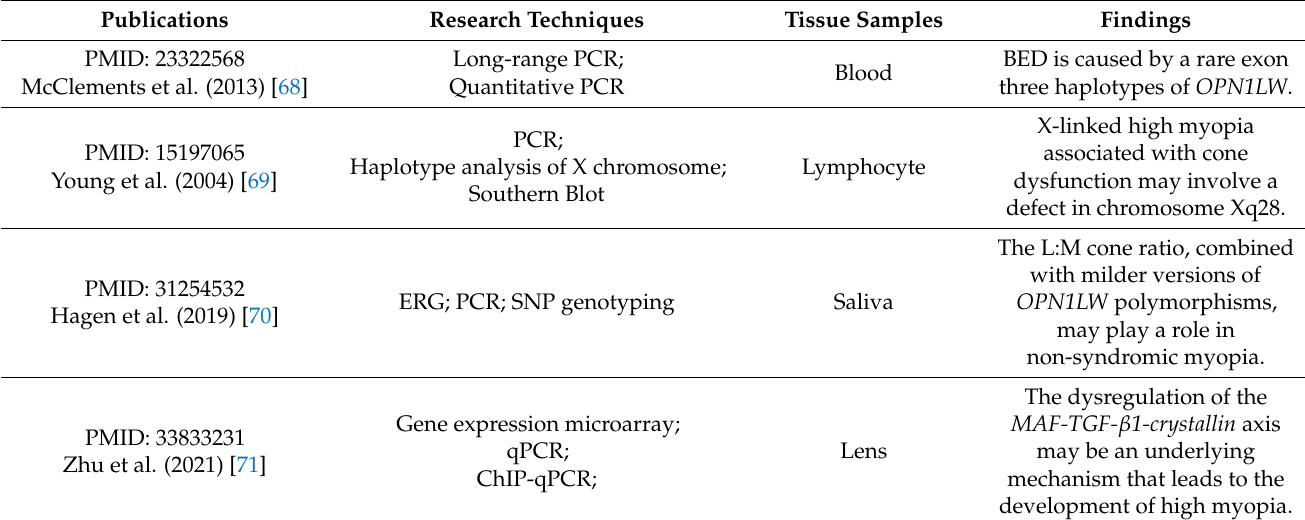
Table 2. Targeted genes in human myopia studies.